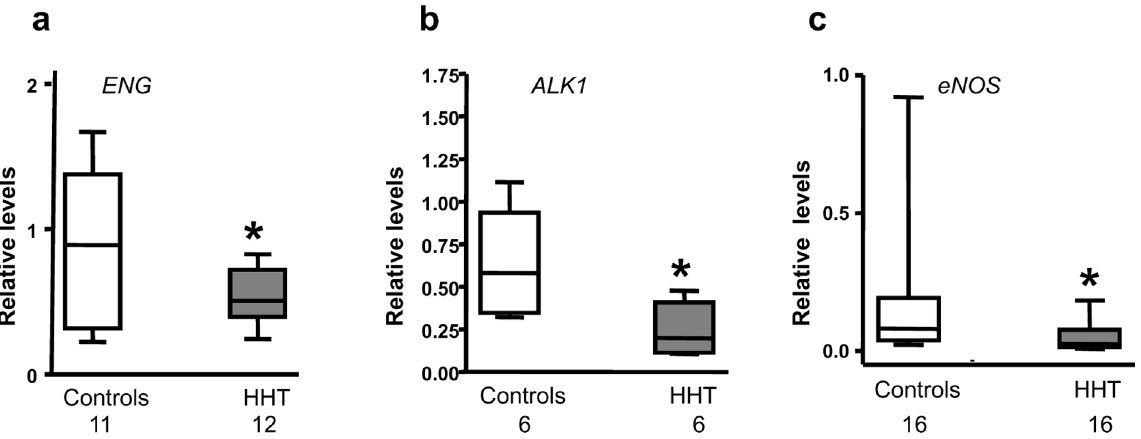
Figure 5. Decreased expression of ENG,ALK1 and eNOS mRNAs in CACs from HHT patients. Relative mRNA levels for ENG, ALK1 and eNOS genes in CACs were measured by real time RT-PCR with b -actin gene serving as an internal control. As shown in this figure, the mRNA levels of all 3 genes detected were significantly lower in CACs from HHT patients than that in CACs from healthy subjects. * p , 0.05, compared with healthy